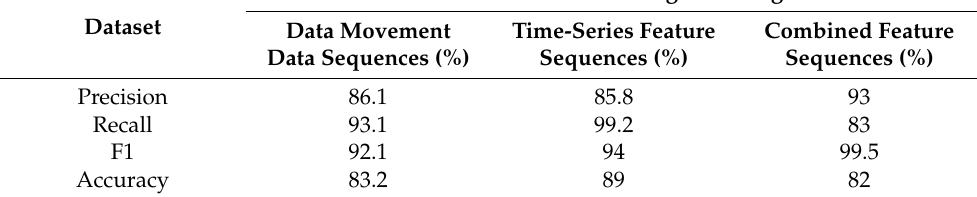
Table 1. Overall Analysis for the teaching of agricultural higher vocational courses based on the BP neural network.